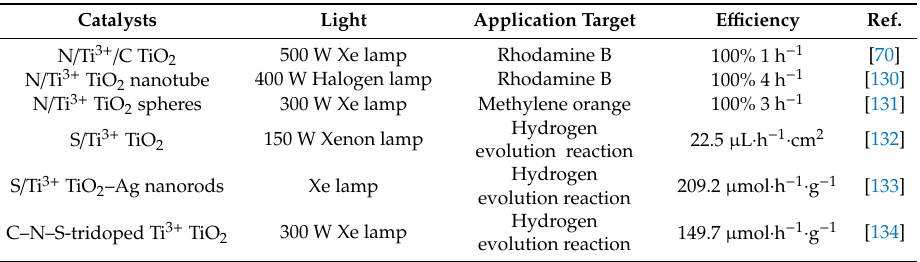
Table 2. Summary of nonmetal doped Ti 3 + self-doped TiO 2 photocatalysts.